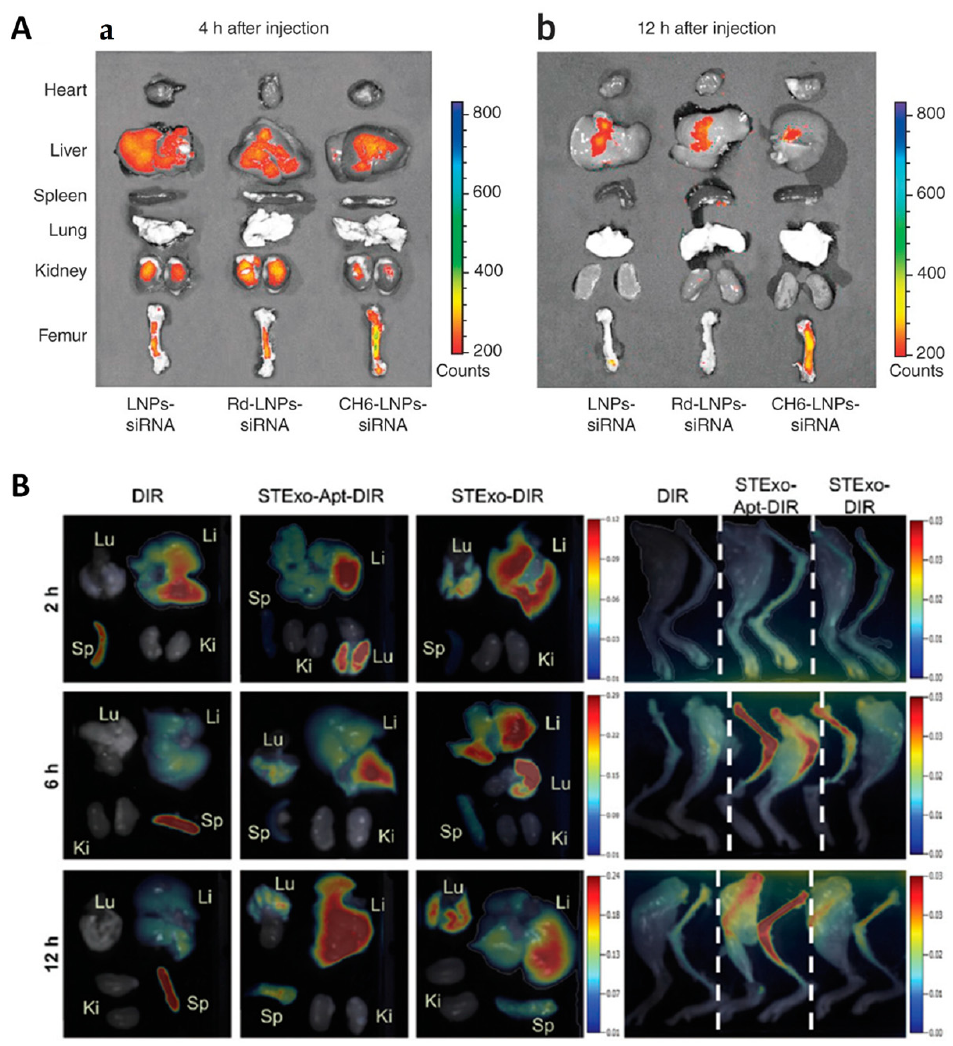
Figure 7. Representative images of the biodistribution of nanocarriers targeted with aptamers